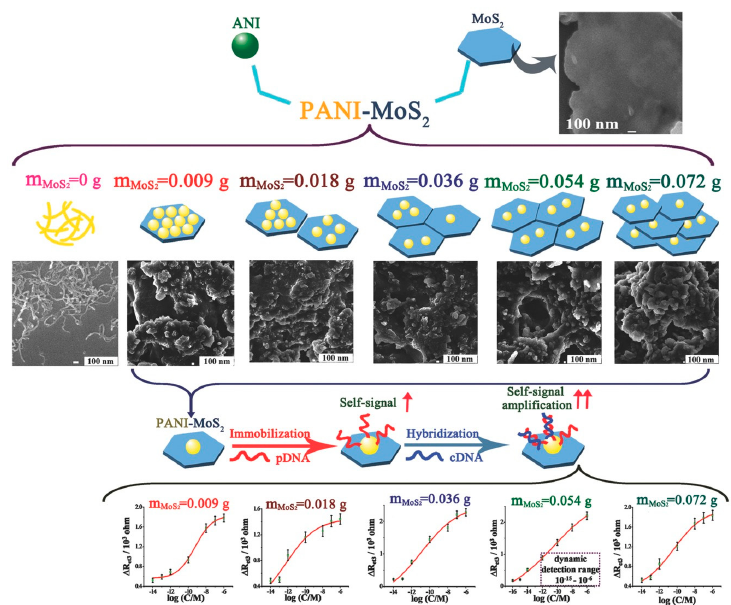
Figure 8. Schematic illustration of conductive polymer polyaniline (PANI)-MoS 2 nanocomposites through facile oxidation polymerization aniline monomer on the thin-layer MoS 2 matrix for electro- chemically sensing cauliflower mosaic virus 35S DNA. The effect of DNA sensitivity of this platform is based on the dosage of MoS 2 with PANI. The figure is adopted and reprinted with permission from Ref. [110]. Copyright Wiley-VCH. (2016).